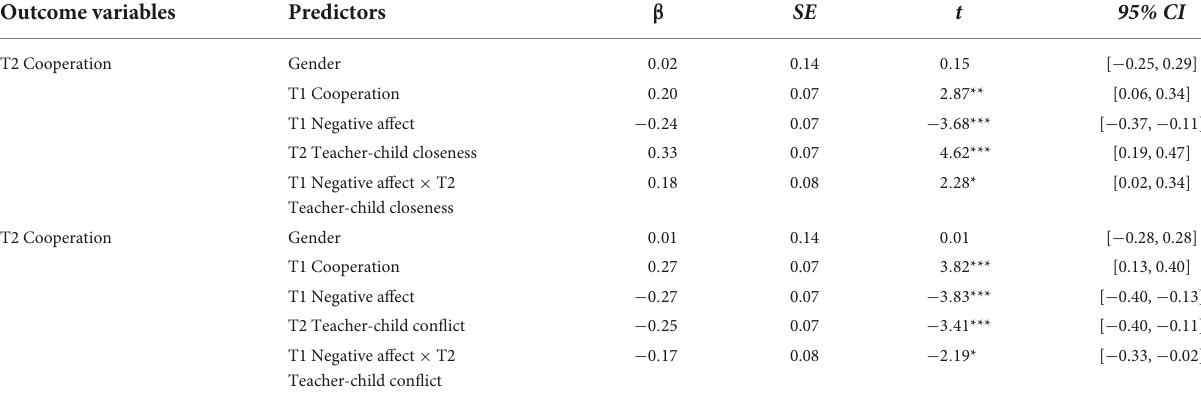
TABLE 2 Moderating effect of negative affect and teacher-child relationship on cooperation. Outcome variables